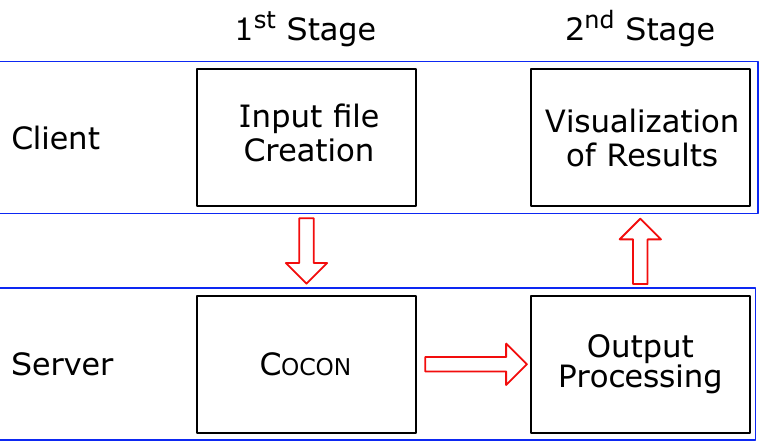
Figure 1. W EB C OCON uses a two-stage workflow. The first stage begins with the input file creation (on the client) followed by the C OCON run, which generates a list of connectivity sets, each set representing one constitution. In the second stage, this set of connectivities is converted into 2D/3D molecular information ranking the candidates that can be visualized on the client. The second stage can be repeated using any of the (currently four) processing methods